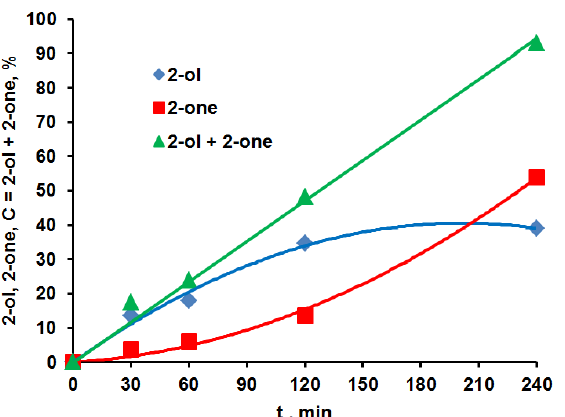
Figure 1. Accumulation of 2 oxidation products 2-ol and 2-one during slow drip introduction of the oxidant solution into the reaction mixture. Equations: %( 2-ol ) = − 0.001t 2 + 0.4022t, R 2 = 0.9867; %( 2-one ) = 0.0008t 2 + 0.0325t, R 2 = 0.9956; C = %( Σ 1O) = %( 2-ol ) + %( 2-one ) = 0.3932t, R 2 = 0.9933.